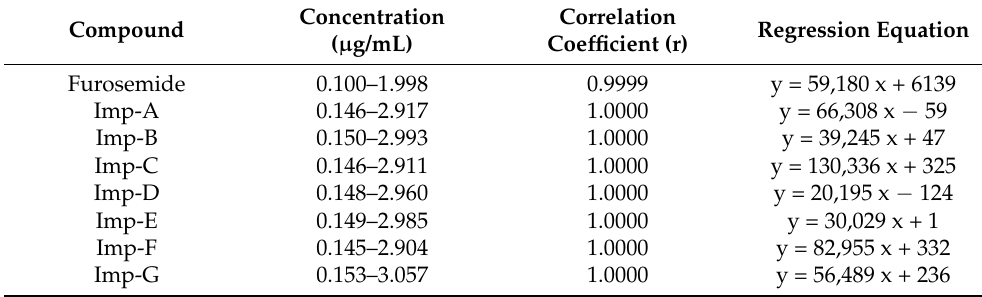
Table 4. Results for linearity and range studies.